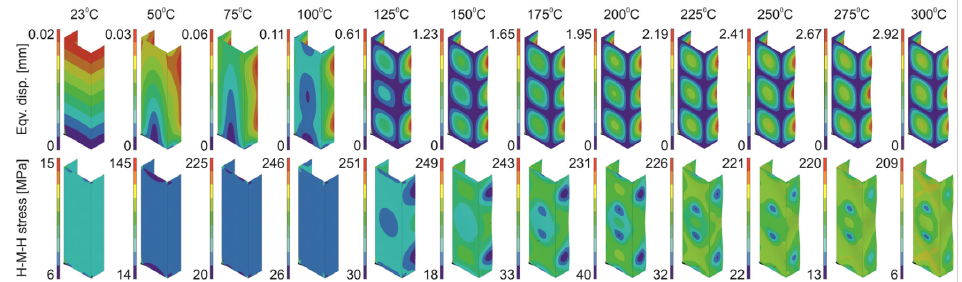
Figure 11. Contour maps of equivalent displacements and H-M-H stresses for heating